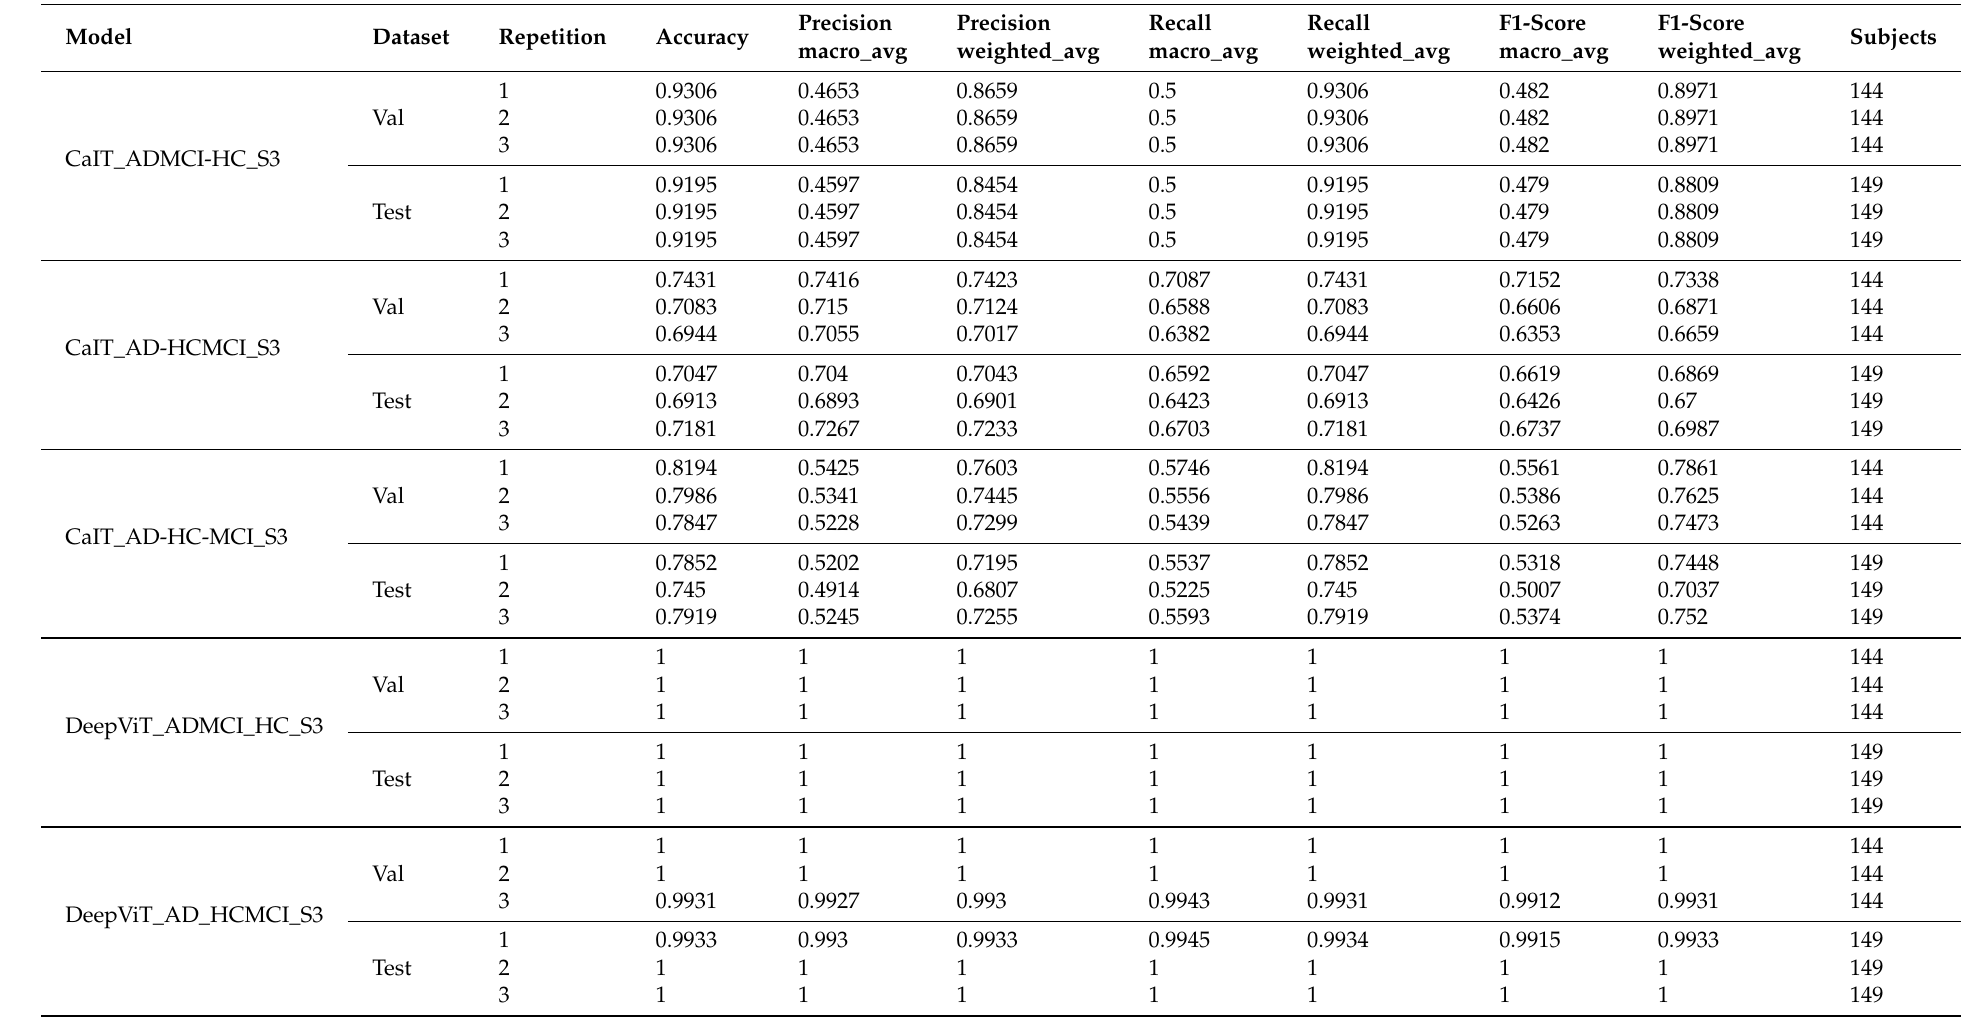
Table A5. The performance of structural MRI models at subject-level for preprocessed data using spatial smoothing with sigma = 3 mm (S3). The naming convention for models and classes is as in the previous